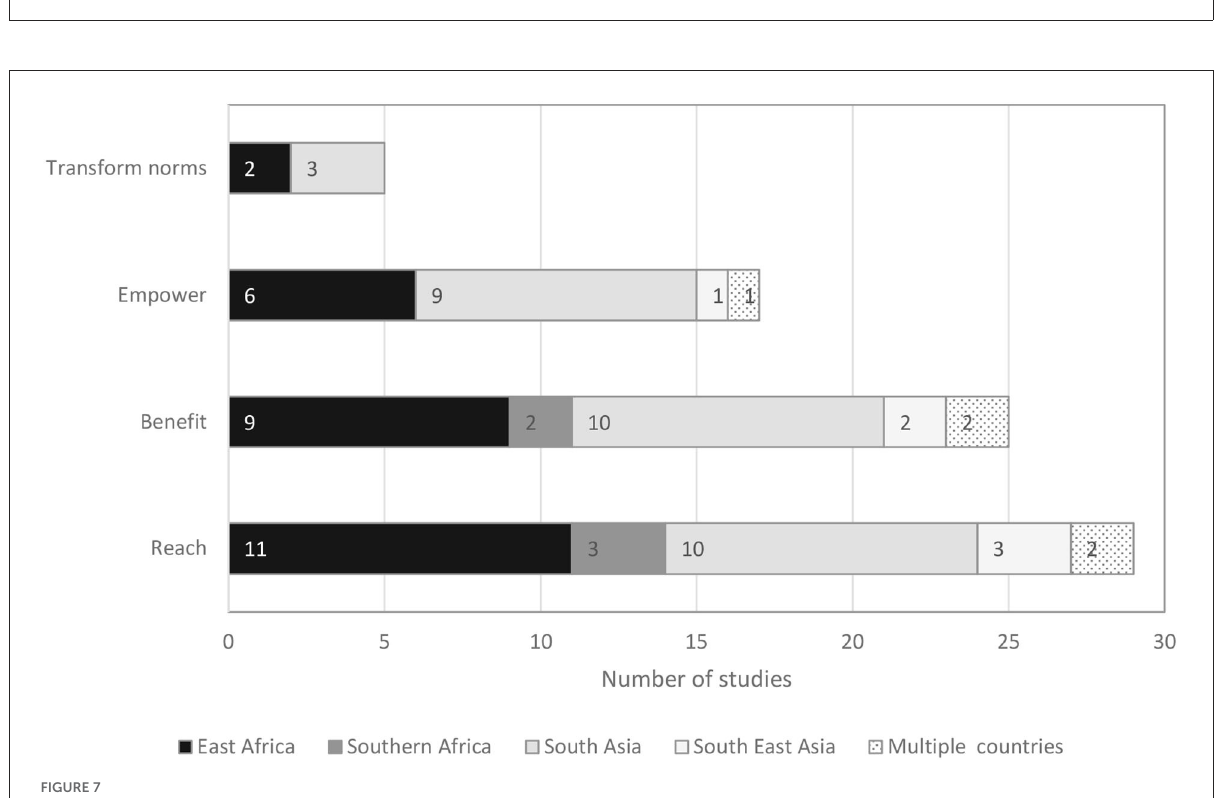
FIGURE6 Number of studies by gender outcomes and livestock species.